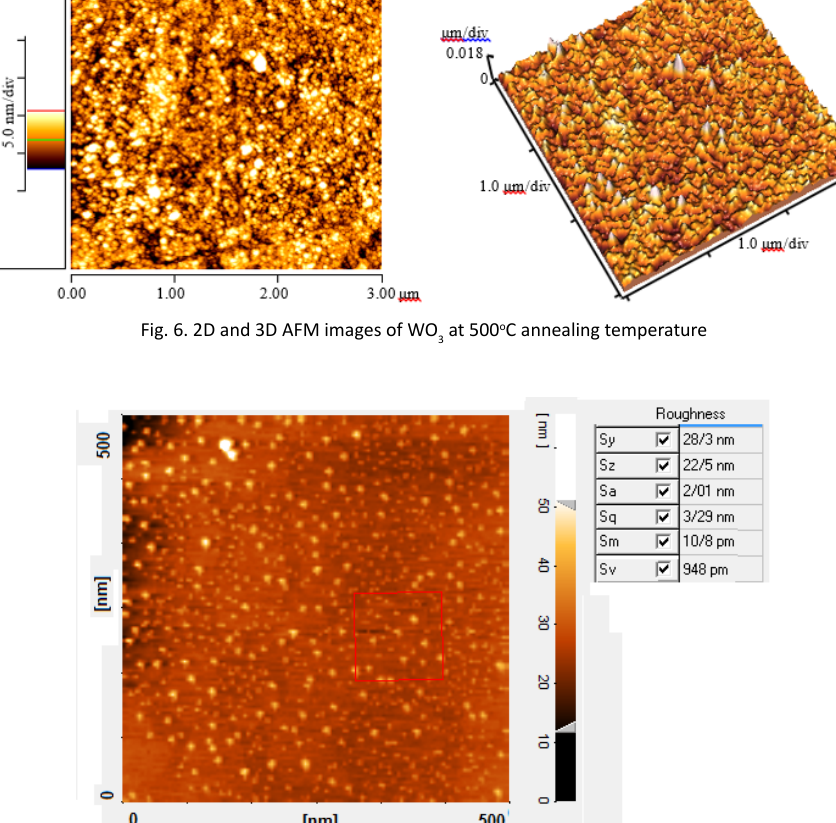
(at 500 o C annealing temperature) are measured with DM-SPM 3